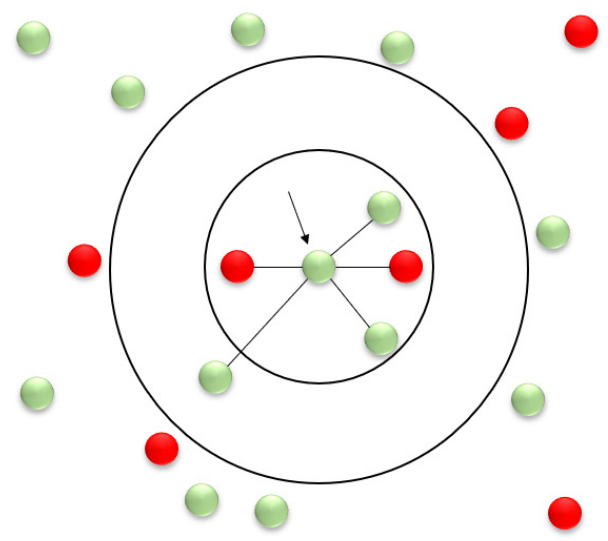
Figure 5. Example for k-nearest neighbour classification using k = 5 neighbours.